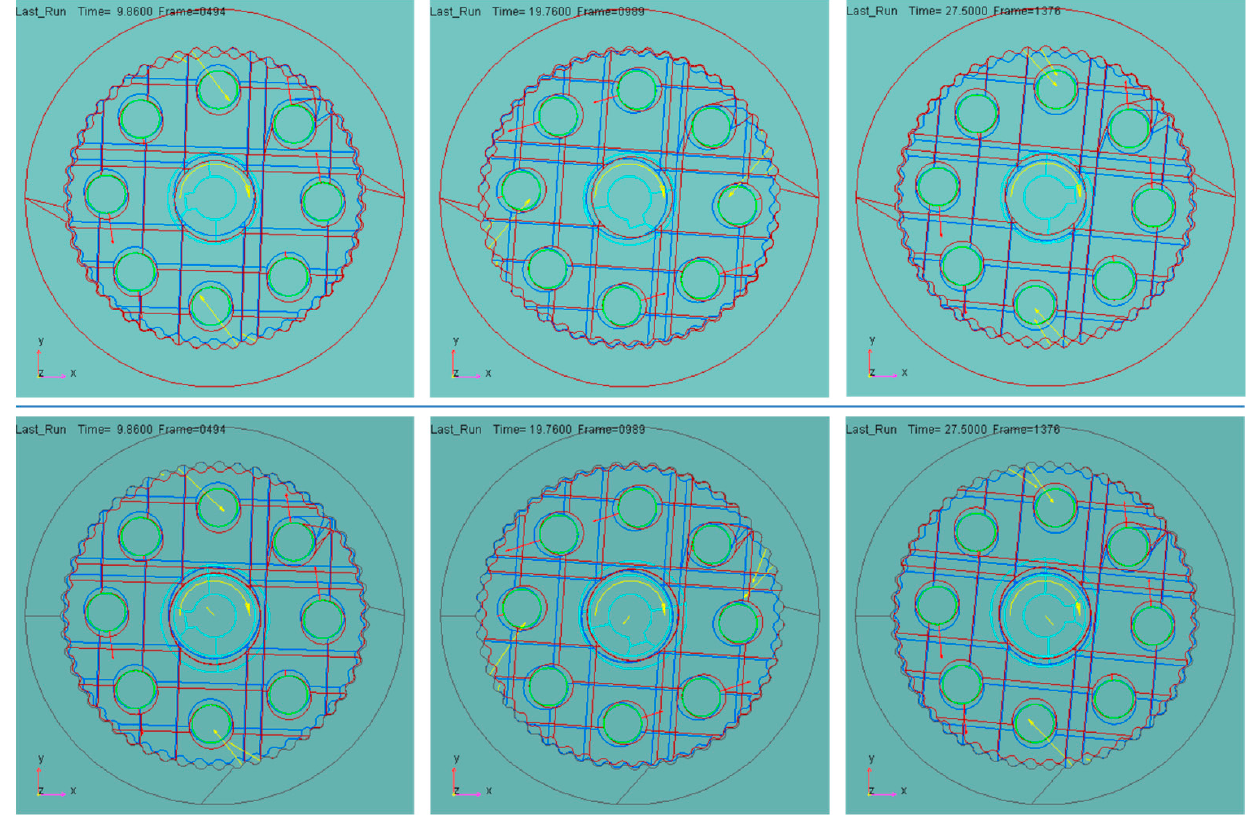
Figure 5. Simulation results of cycloidal reducer with 49:1 ( top ), 50:1 ( below ). At an even reduction ratio (50:1), the two disks are aligned exactly 180 ◦ to each